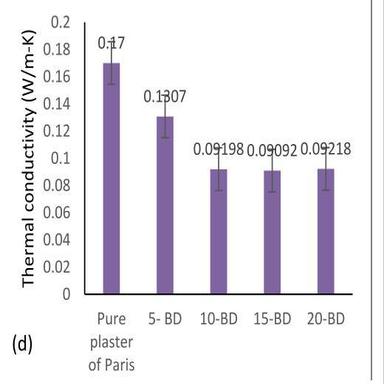
Physico-chemical properties (a) density (b) compression strength, (c) water absorption, (d) thermal conductivity, and (e) tensile strength.